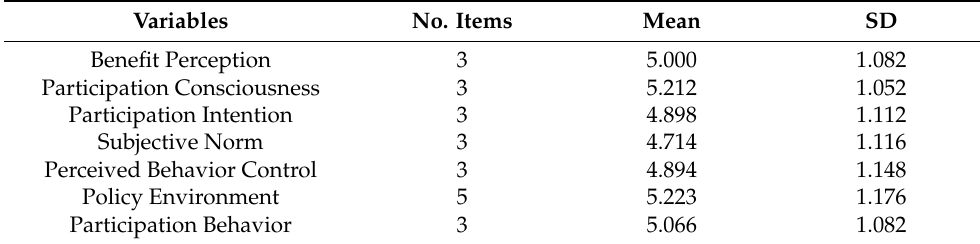
Table 2. Descriptive